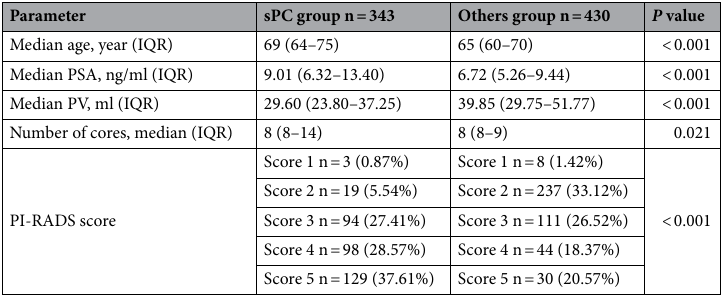
Table 1. Clinical parameters and MRI PI-RADS score both 2 groups. IQR interquartile range, PI-RADS prostate imaging reporting and data system, SA prostate-specific antigen, PV prostate volume, sPC clinically significant prostate cancer.